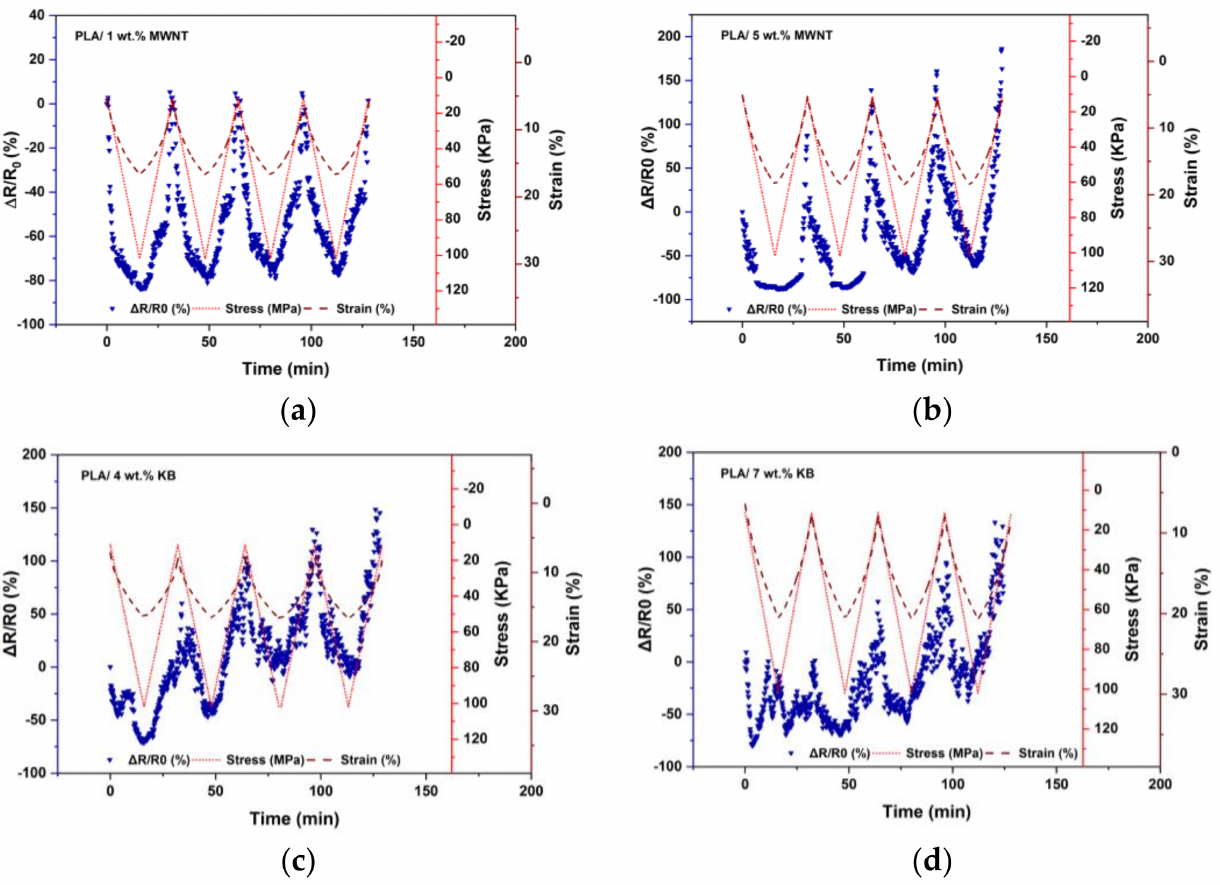
Figure 4. Comparison of 3D-printed nanocomposites piezoresistive responses: ( a ) PLA/1 wt.% MWNT, ( b ) PLA/5 wt.% MWNT, ( c ) PLA/4 wt.% KB and ( d ) PLA/7 wt.%